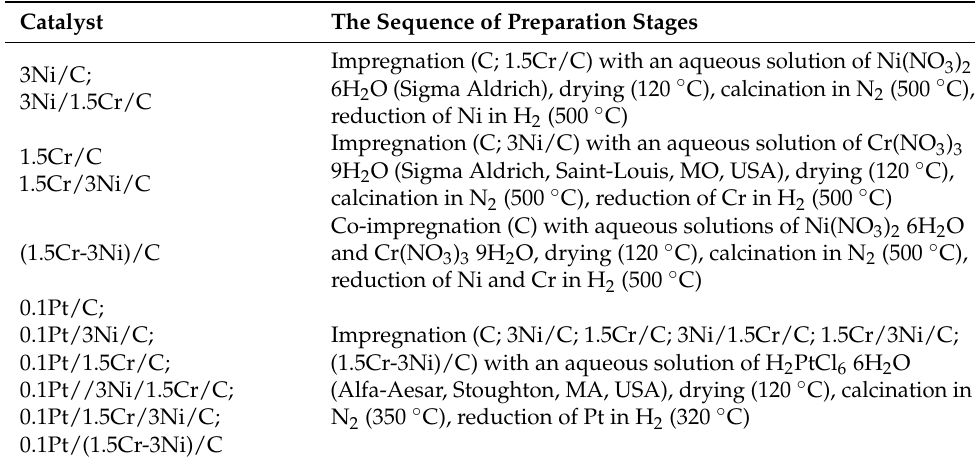
Table 5. Conditions for the preparation of